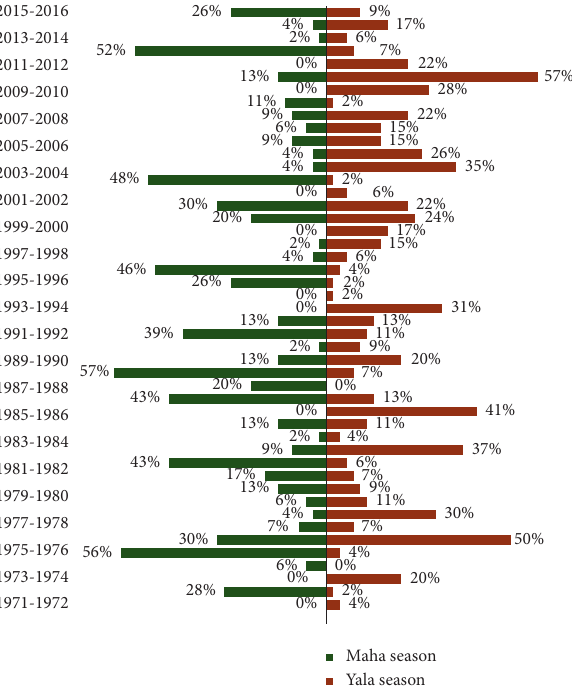
Figure 3: Occurrence of drought events (SPI ≤ − 1) during Yala and Maha seasons as a % of stations.